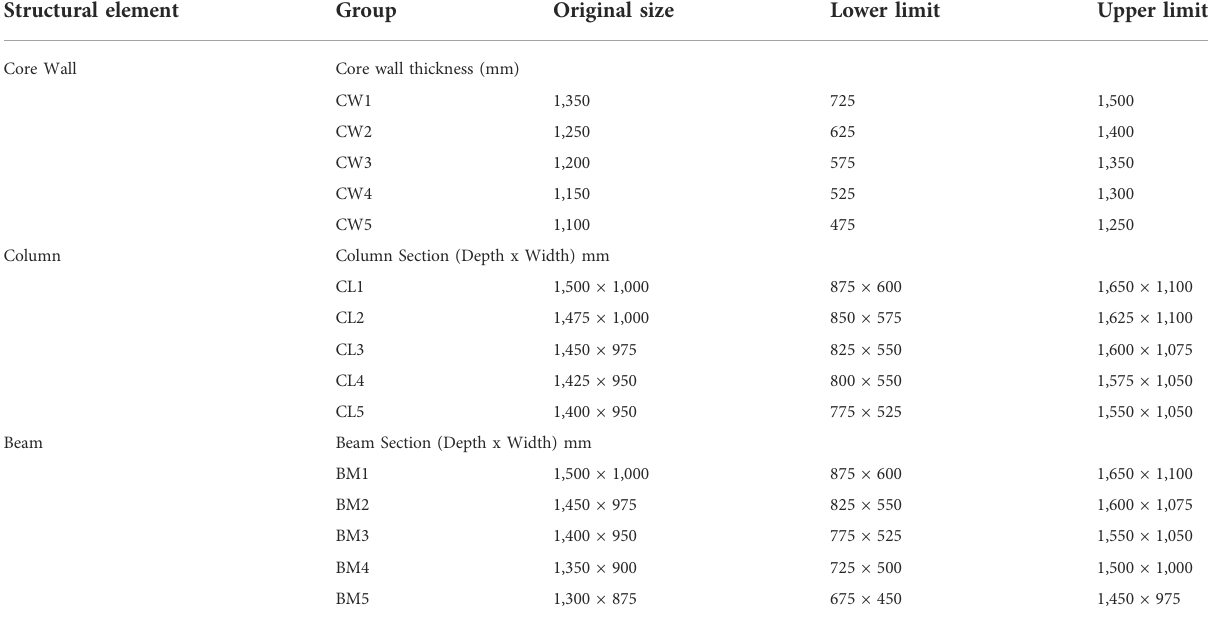
TABLE 1 Structural sections